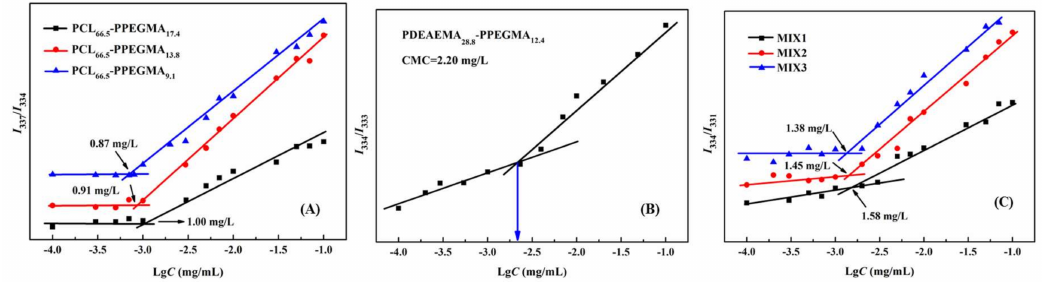
Figure 2. Di ff erent ratios of pyrene in neutral aqueous solution for PCL-PPEGMA ( A ), PDEAEMA-PPEGMA ( B ), and mixed polymers ( C ) at various